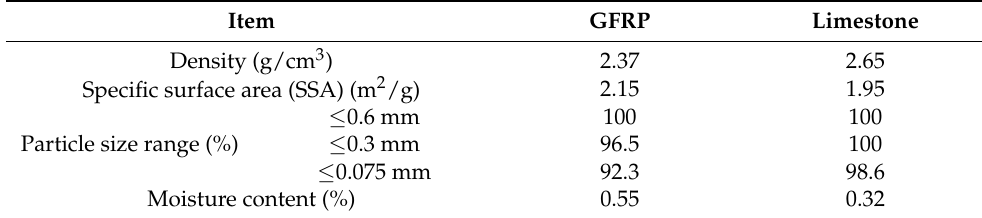
Table 2. Basic Properties of Waste GFRP Powder and Limestone